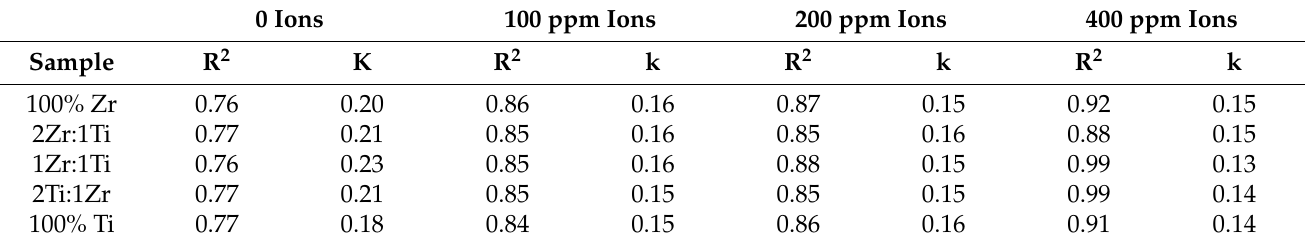
Table 8. Kinetic summary of